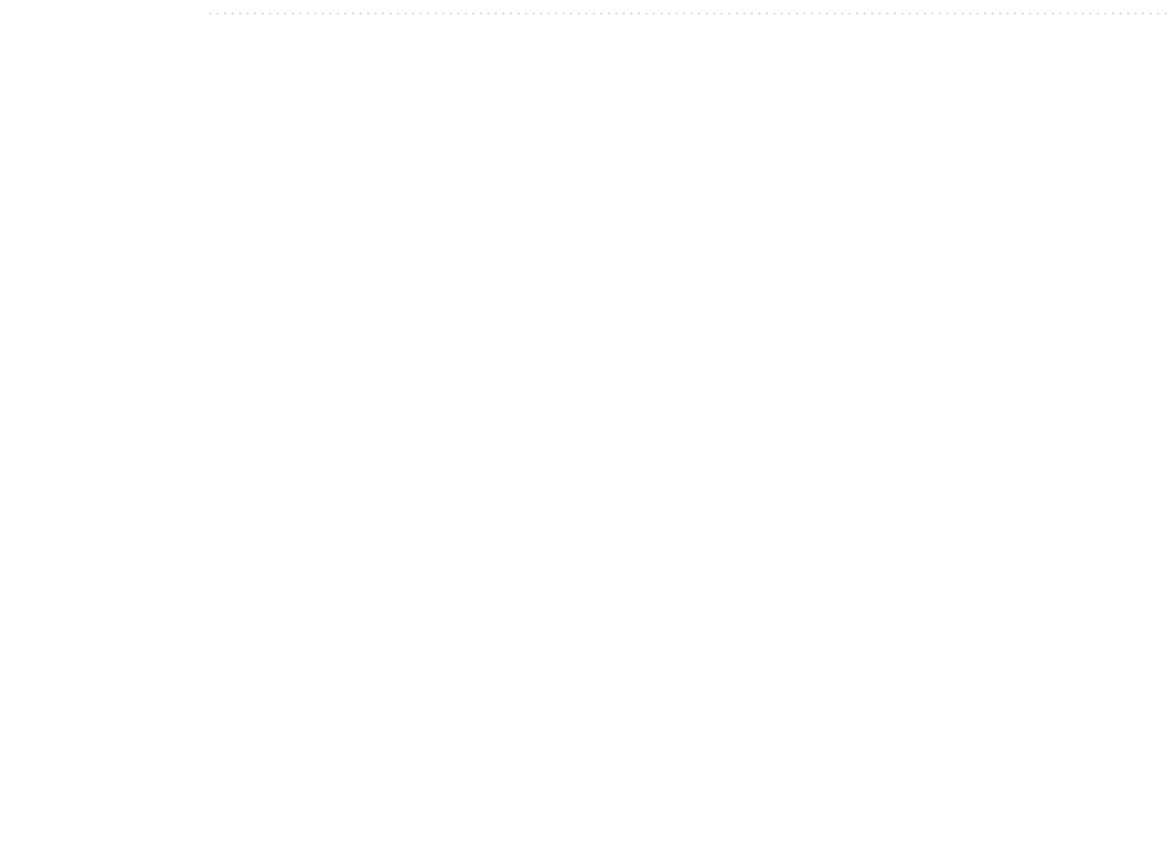
Figure 9. The period of I with different degree and ρ , when β = 0.8